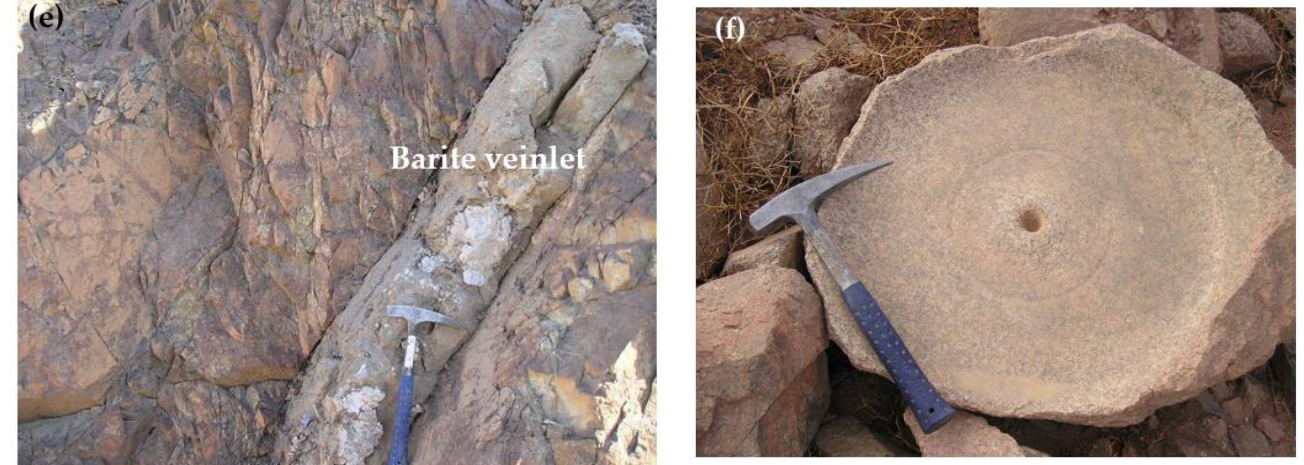
Figure 3. ( a ) Monzogranite (mgr) was intruded by Hammamat sediments (ham). ( b ) Alteration zones of Wadi Makhrag El Ebel bearing Cu, Au, and Ba mineralization. ( c ) Monzogranite-enclosed copper mineralization in south Monqul, Wadi Makhrag El Ebel. ( d ) Copper mineralization extracted from the area along the strike of the intersection between two conjugate normal fault systems in monzogranites trending E – W. ( e ) Barite-veinlet-dissected acidic volcanics having ENE – WSW trends. ( f ) Manual mill from monzogranite used for grinding quartz bearing gold.